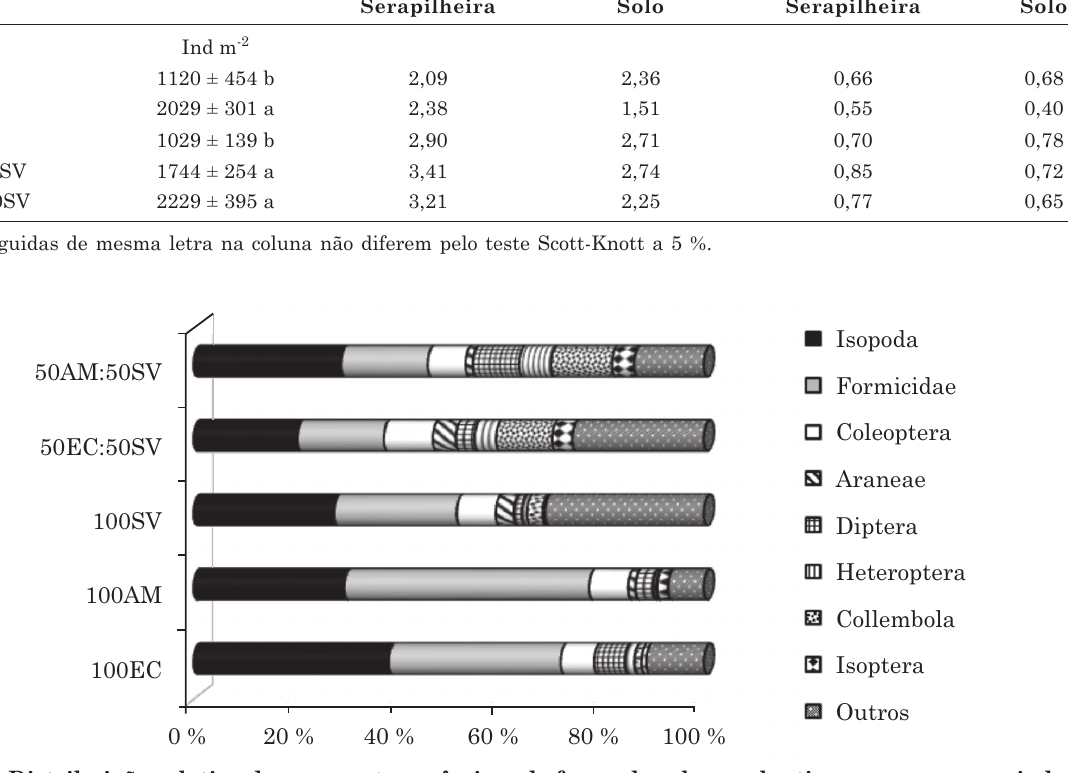
Figura 1. Distribuição relativa dos grupos taxonômicos da fauna do solo em plantios puros e consorciados de Eucalyptus camalsulensis (EC) e Acacia mangium (AM) com Sesbania virgata (SV), em cava de extração de